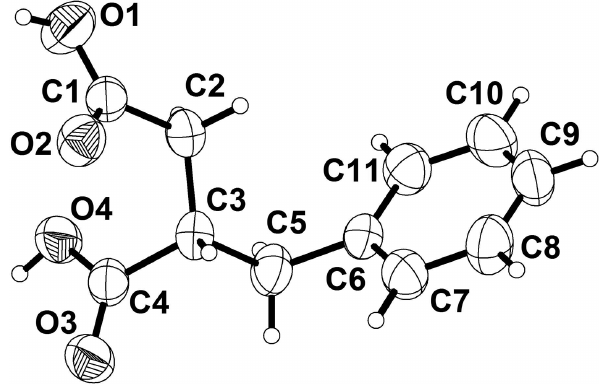
Table 2: Fractional atomic coordinates and isotropic or equivalent isotropic displacement parameters (Å 2